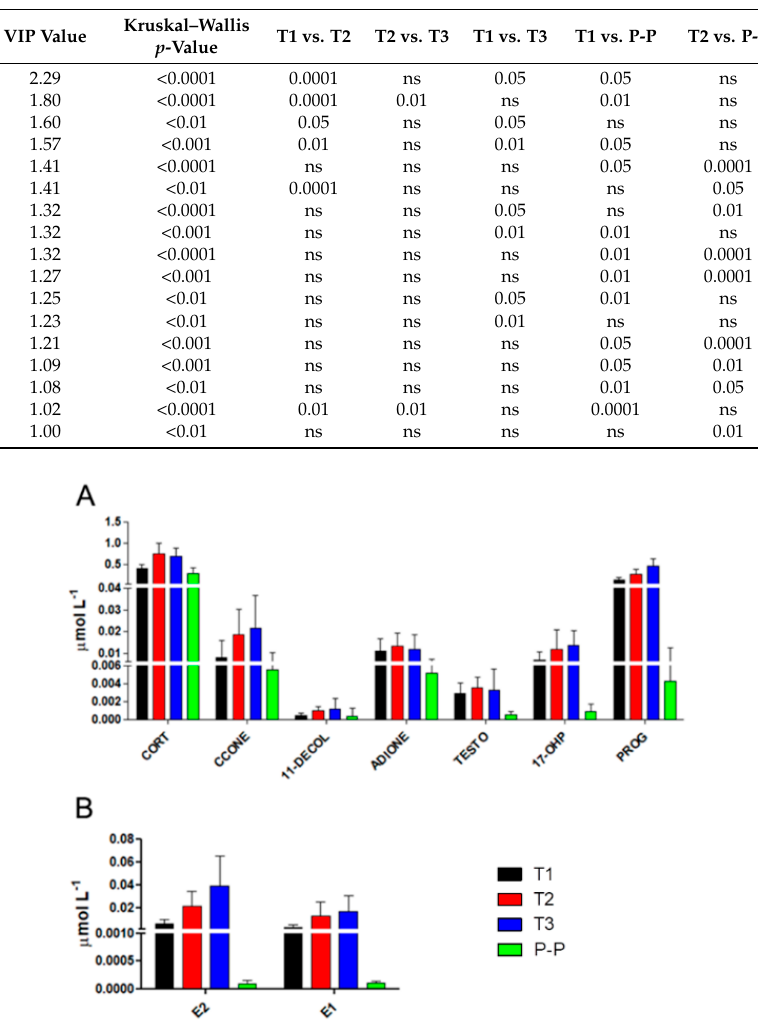
Figure 2. ( A , B ) Concentrations of steroids and estrogens in each of the three trimesters of pregnancy and post-partum (P-P) as follow: black bars for the first trimester of pregnancy, red bars for the second trimester of pregnancy, blue bars for the third trimester of pregnancy, and green bars for the post-partum period. Data are mean values, and bars represent the corresponding standard deviations (SD). The significance, expressed in terms of p -value, is reported in Table 2 for each time comparison for the observed steroids and estrogens. CORT: cortisol, CCONE: corticosterone, 11DECOL: